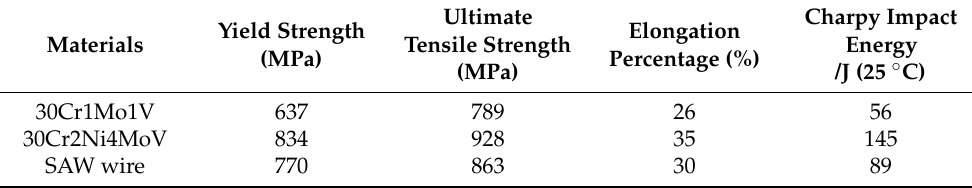
Table 2. Mechanical properties of base and deposited metals.